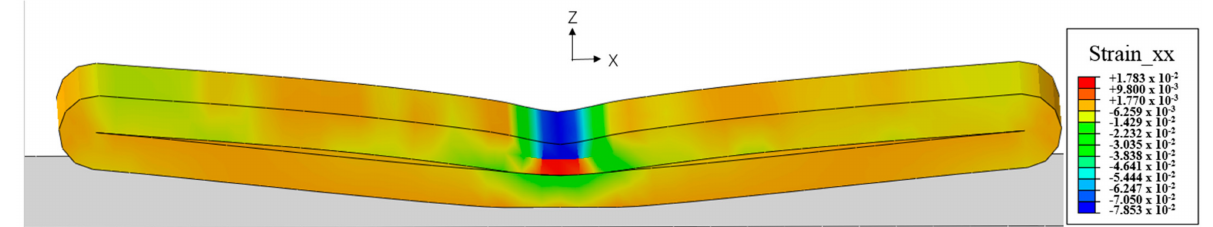
Figure 9. X component of strain during indentation simulation along Z direction.